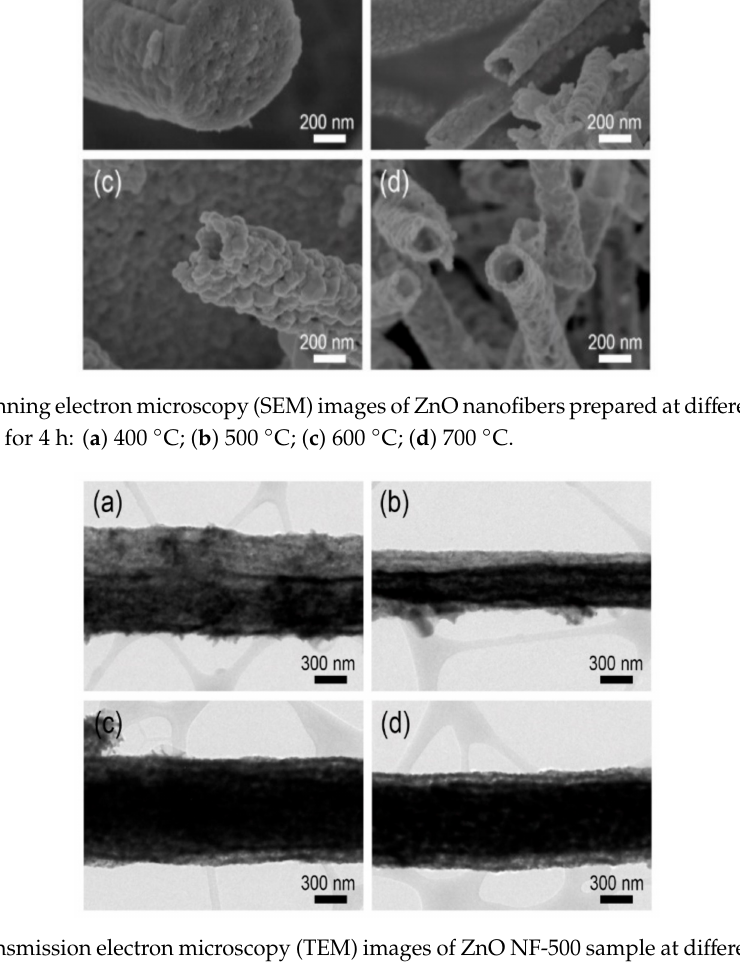
Figure 2. Transmission electron microscopy (TEM) images of ZnO NF-500 sample at di ff erent annealing times: ( a ) 1 h; ( b ) 2 h; ( c ) 3 h; ( d ) 4